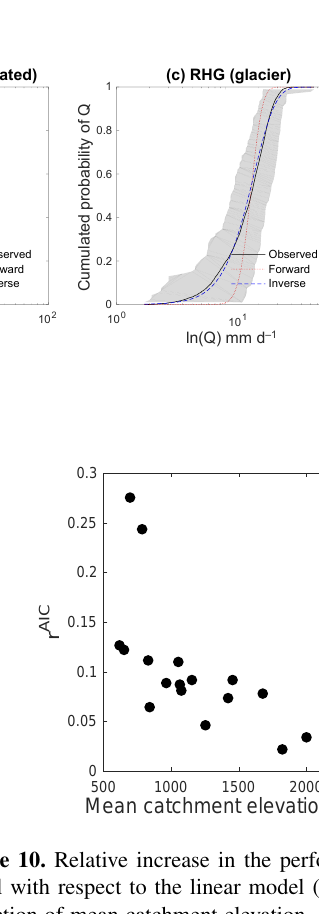
Figure 7. Modeled cdfs with forward and inverse parameter estimation for the three selected catchments. The shaded area is located between the cdf envelopes and represents the natural variability of the daily discharges.